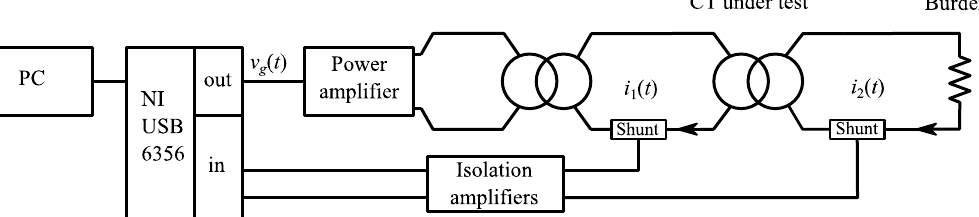
Figure 5. Block diagram of the experimental setup.